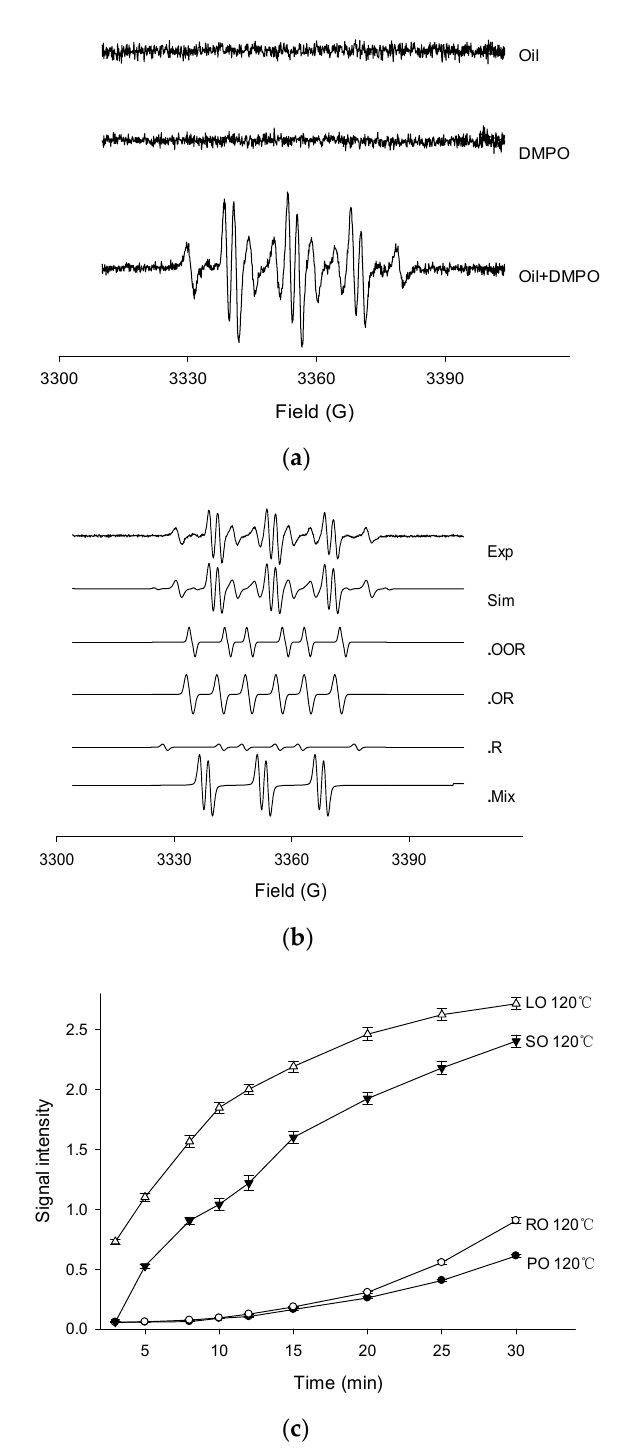
Figure 1. The EPR spectrums of palm oil ( a ), experimental and simulated EPR spectrums of palm oil ( b ) and signal intensities of four oils heated at 120 °C ( c ). (Note: Exp, experimental